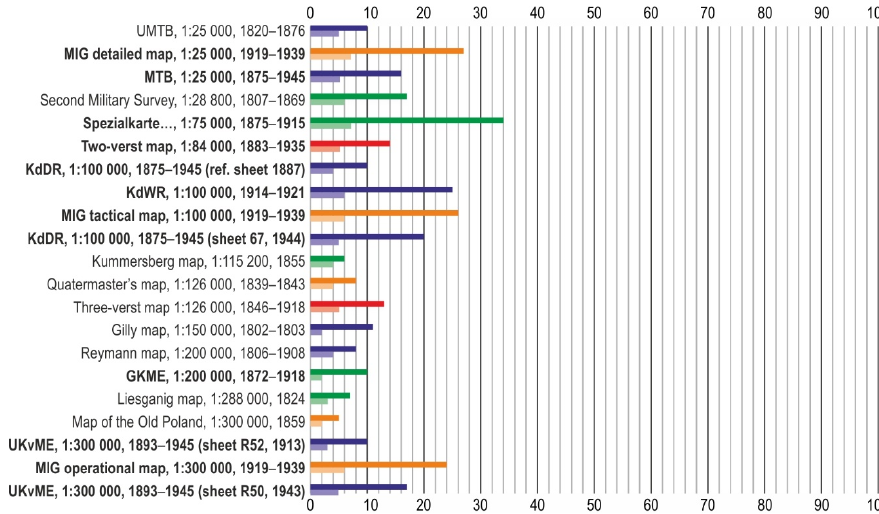
Fig. 3. Number of feature types on different maps’ key to symbols among “communication network” feature class category (before and after